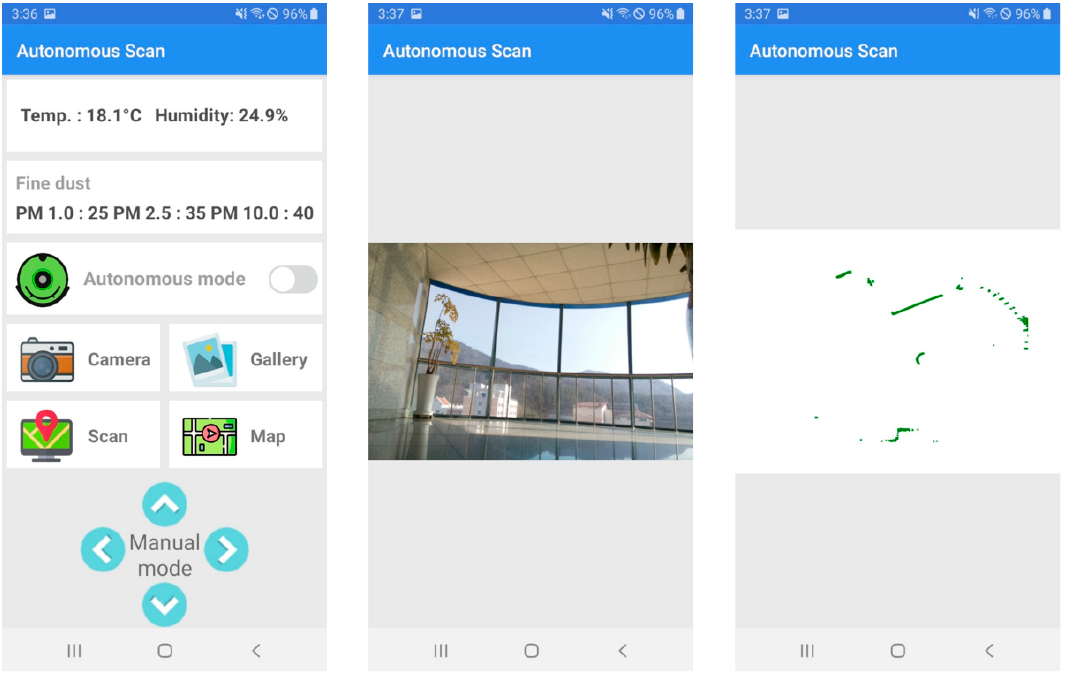
Figure 12. Environmental data result ( left ), captured image ( middle ) and scanned result ( right ) for movement in lobby.